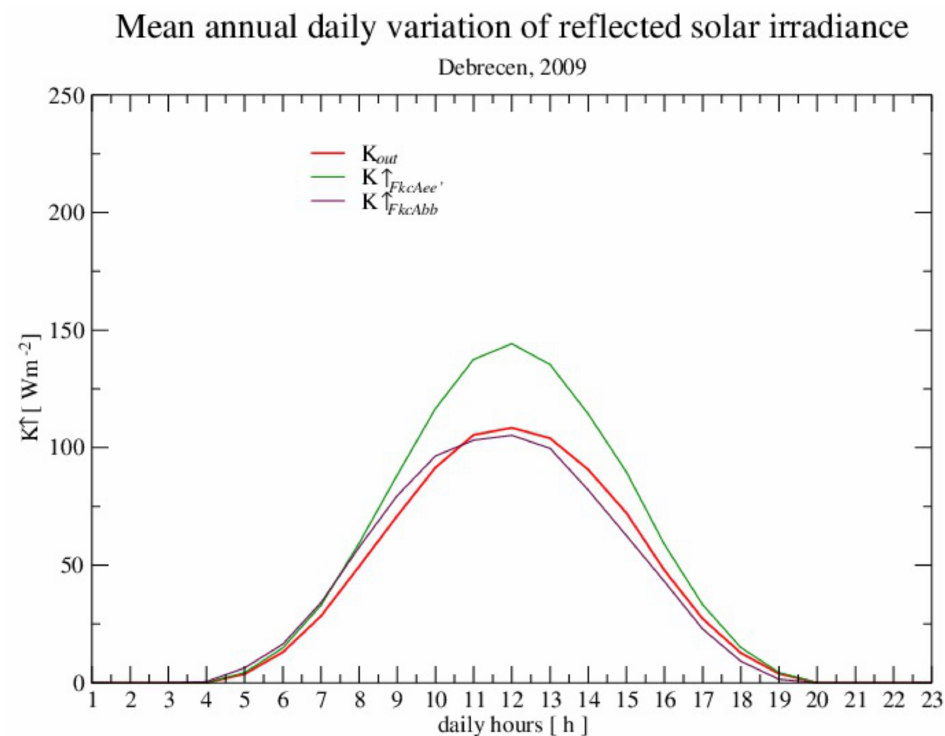
Figure 4. Comparisons between the measurements ( K out ) and two models for the calculation of shortwave reflected solar irradiance (a) (green line) albedo calculations based on the Nyren and Gryning [37] model, K ↑ FkcAee (cid:48) and (b) (violet line) using Beljaars and Bosveld [38] methodology, K ↑ FkcAbb . Foken’s calculations for clear skies and Kasten and Czeplak [39]-type cloud parameteri- zation was used for the global solar radiation